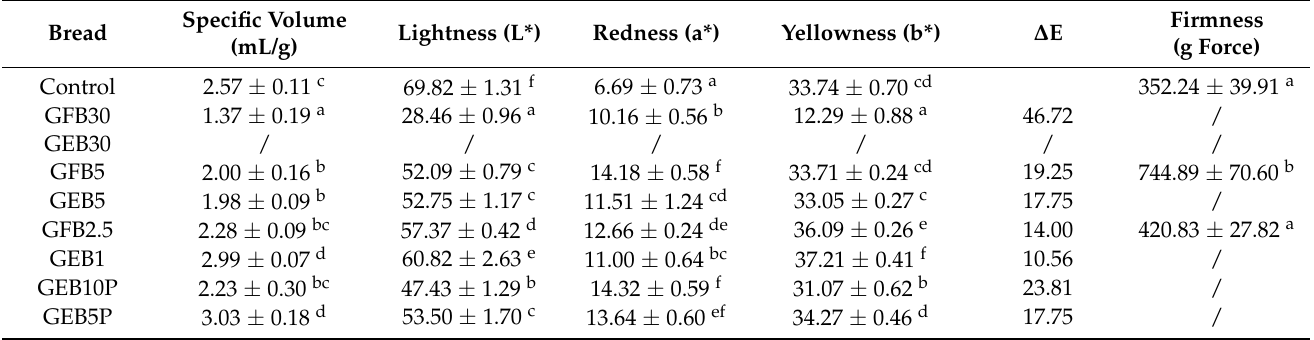
Table 2. Quality parameters of bioprocessed breads compared to the control